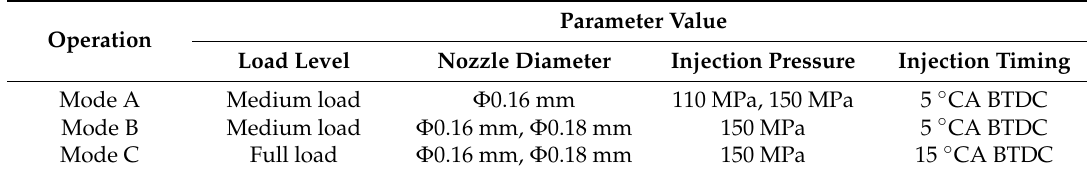
Table 4. Parameter values of operation